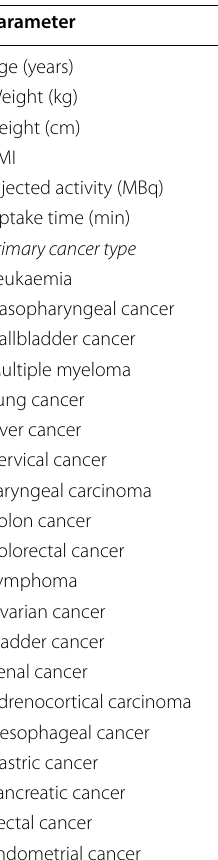
Table 1 Patient demographic